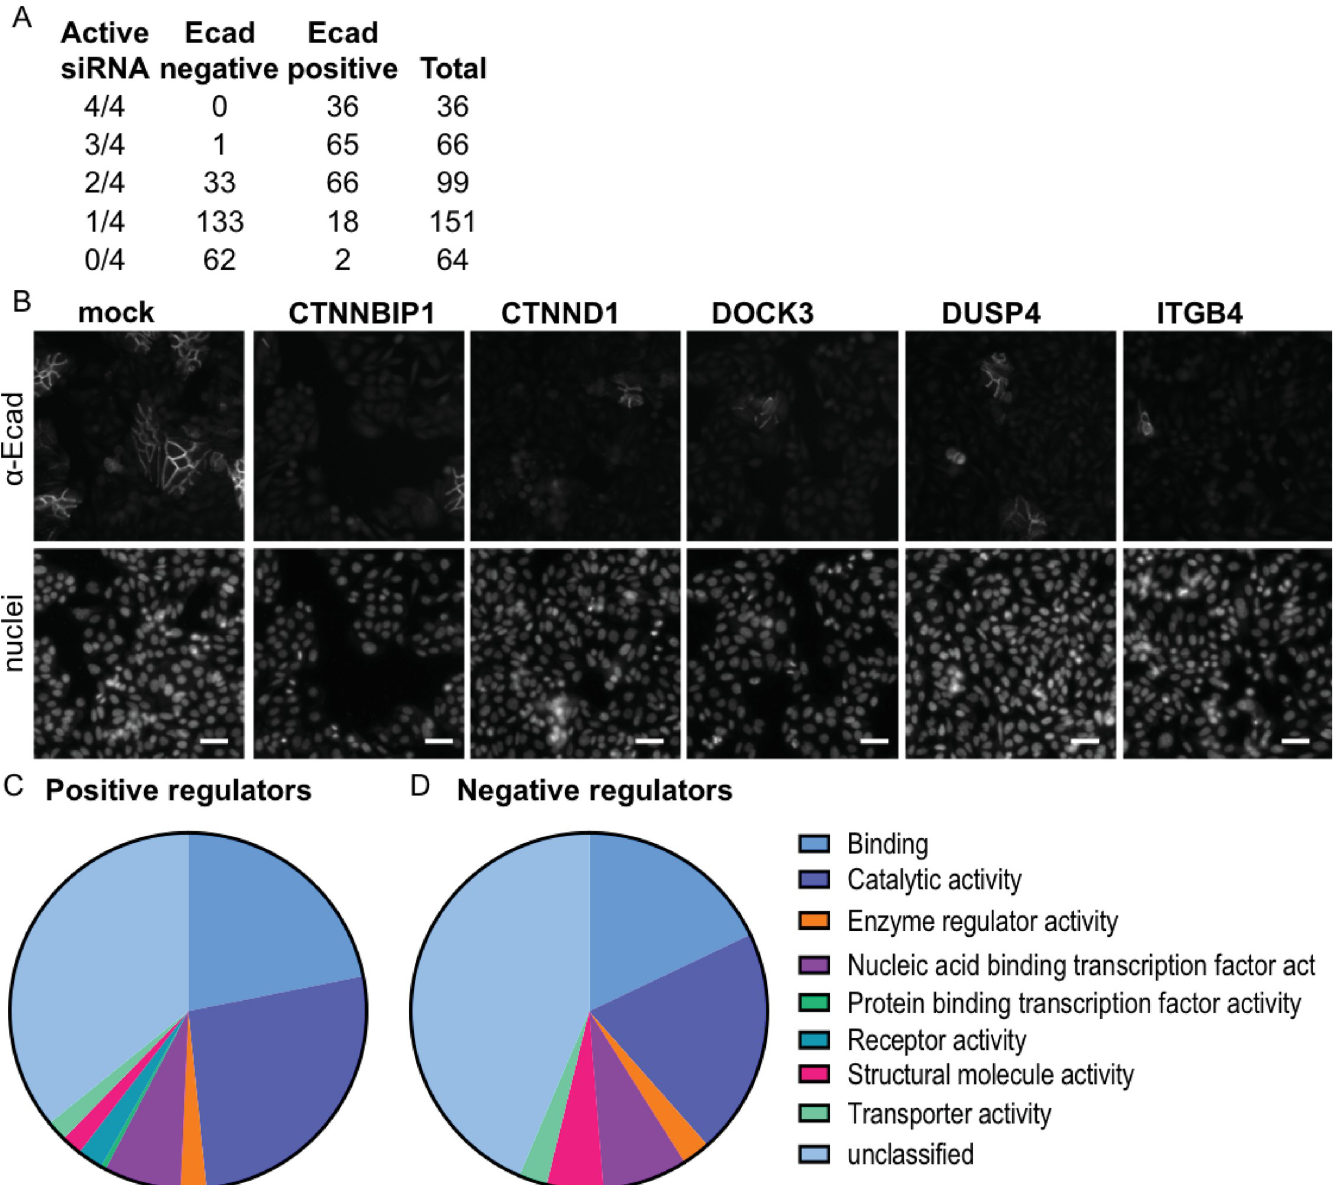
Fig 4. siRNAs which alter SW480-membrane-associated E-cadherin. (A) Summary of the outcome of the secondary validation screen. The number of active siRNA for E-cadherin negative and positive regulators are indicated. At least 2 out of 4 siRNA duplexes must statistically recapitulate the primary SMARTpool screen to be considered a hit. (B) Representative images from the deconvoluted screen of α E-cadherin and Hoechst staining, 72 hours post transfection of positive regulators with selected duplex siRNAs (25nM) for mock, CTNNBIP1 , CTNND1 , DOCK3 , DUSP4 and ITGB4 . Scale bar; 50 μ M, 20x magnification. (C and D) Functional categorization of candidate E-cadherin positive (C) and negative (D) regulatory genes identified from the screen (Panther Classification GO-Slim Molecular Functions, System Version 15.0). https://doi.org/10.1371/journal.pone.0240746.g004 proliferation [38] and in promoting E-cadherin expression in non-small cell lung cancer [39]. Gene ontology (GO) analysis showed that genes identified as both positive and negative regu- lators of E-cadherin are enriched for ‘Binding’ and ‘Catalytic Activity’ (Fig 4C and 4D; S2 and S3 Tables) and many of them function in cell-cell adhesion and endocytosis. In addition, STRING analysis which assesses and integrates protein associations [40] showed a significant